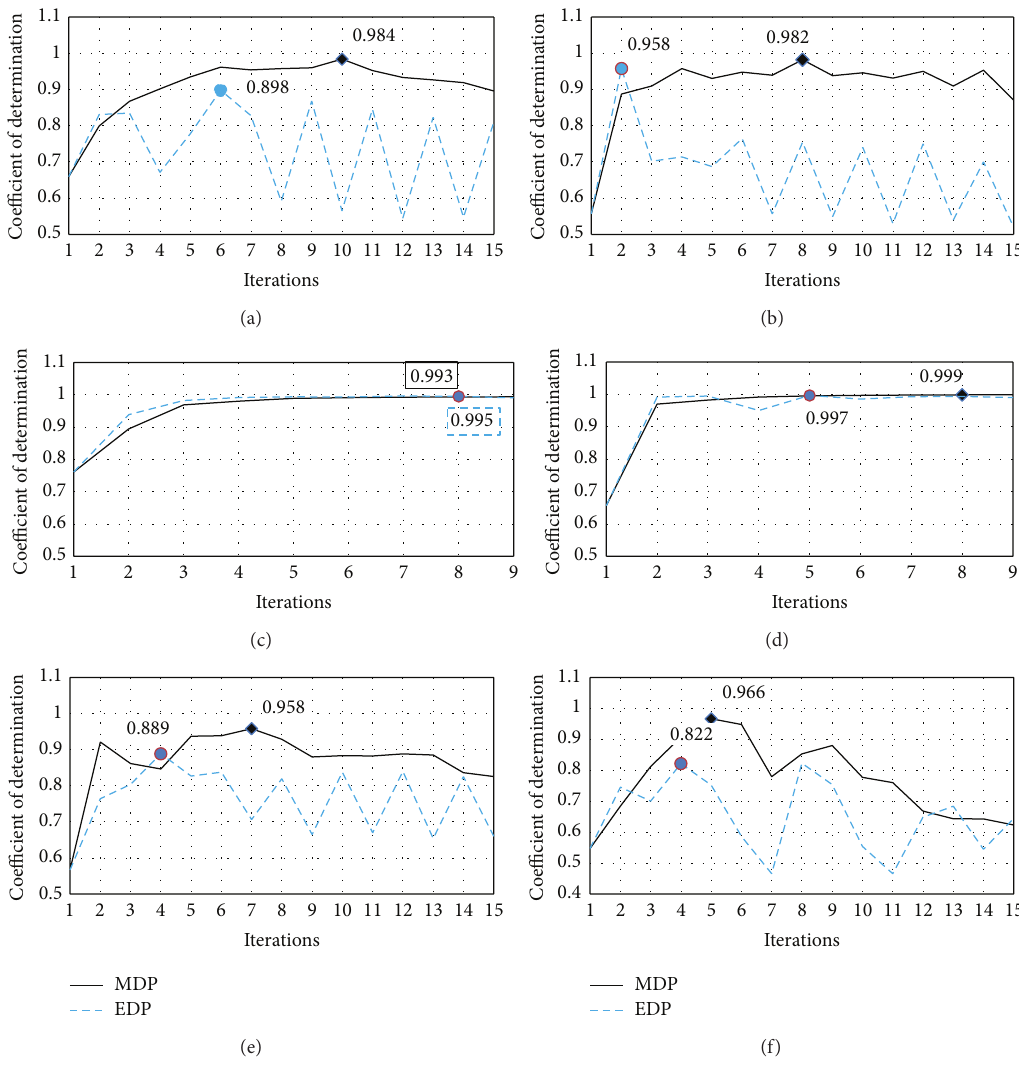
Figure 7: Coefficient of determination ( 𝑅 2 ) for deconvolved ground motions for Geometry G1: (a) M number 3(H); (b) M number 3(V); (c) V number 2(H); (d) V number 2(V); (e) V number 3(H); and (f) V number